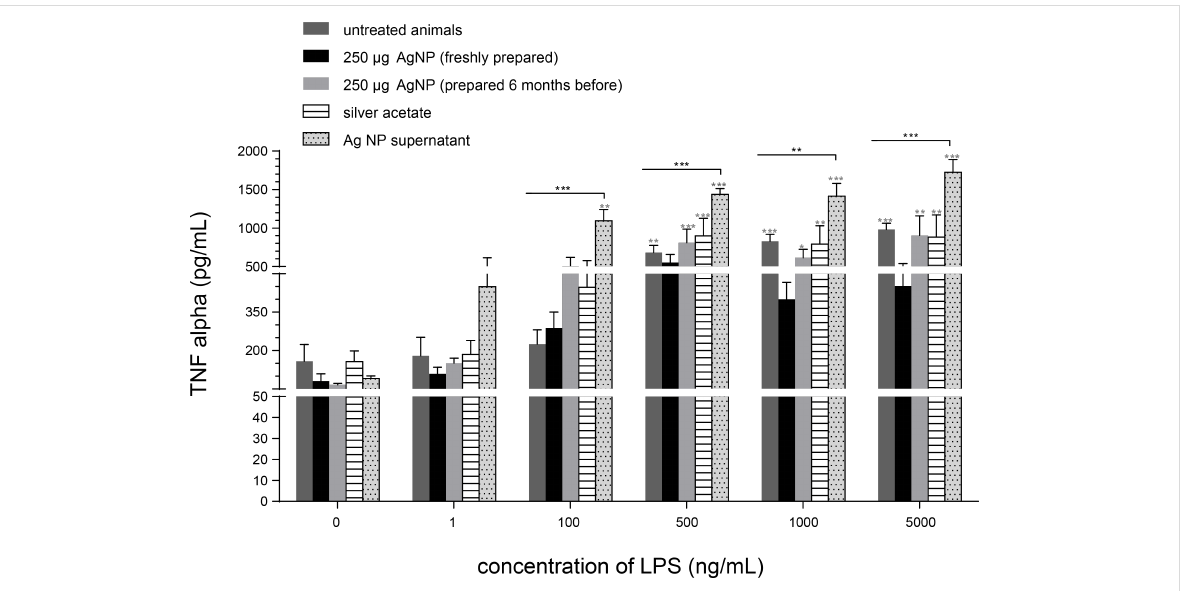
Figure 8: Release of TNF- α in the supernatant after 4 h of incubation of PCLS (of untreated animals or animals treated with 250 µg AgNP (freshly prepared or aged for six months), or silver acetate (250 µg Ag + ) or AgNP-free supernatant) with increasing LPS-concentrations in the tissue culture medium. The instilled volume was always 80 µL. Data are represented as mean ± SEM; n = 4–7; *,**,***: significantly different from PCLS exposed to 0 ng/mL LPS; *,**,***: significantly different from PCLS of untreated animals; p < 0.05 (*), p < 0.01 (**), p < 0.001